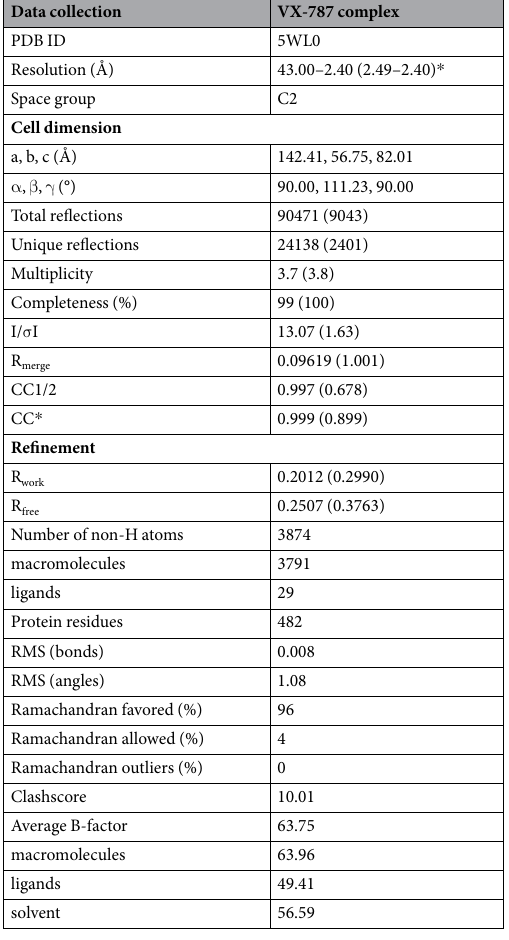
Table 1. Data collection and refinement statistics. * Values in parentheses are for highest-resolution shell. A single crystal was used for this structure. ** R work and R free were calculated from the working and test reflection sets, respectively. The test set contained 5% of the total reflections